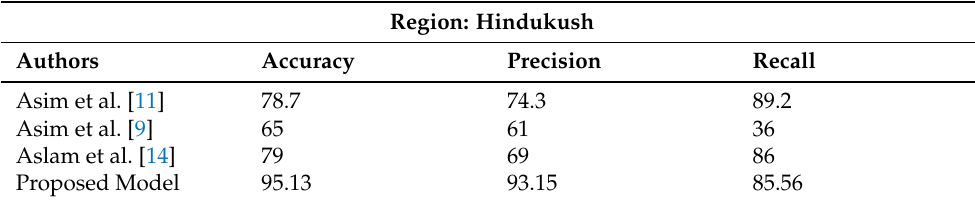
Table 8. Performance comparison of extant studies to proposed model for Hindukush